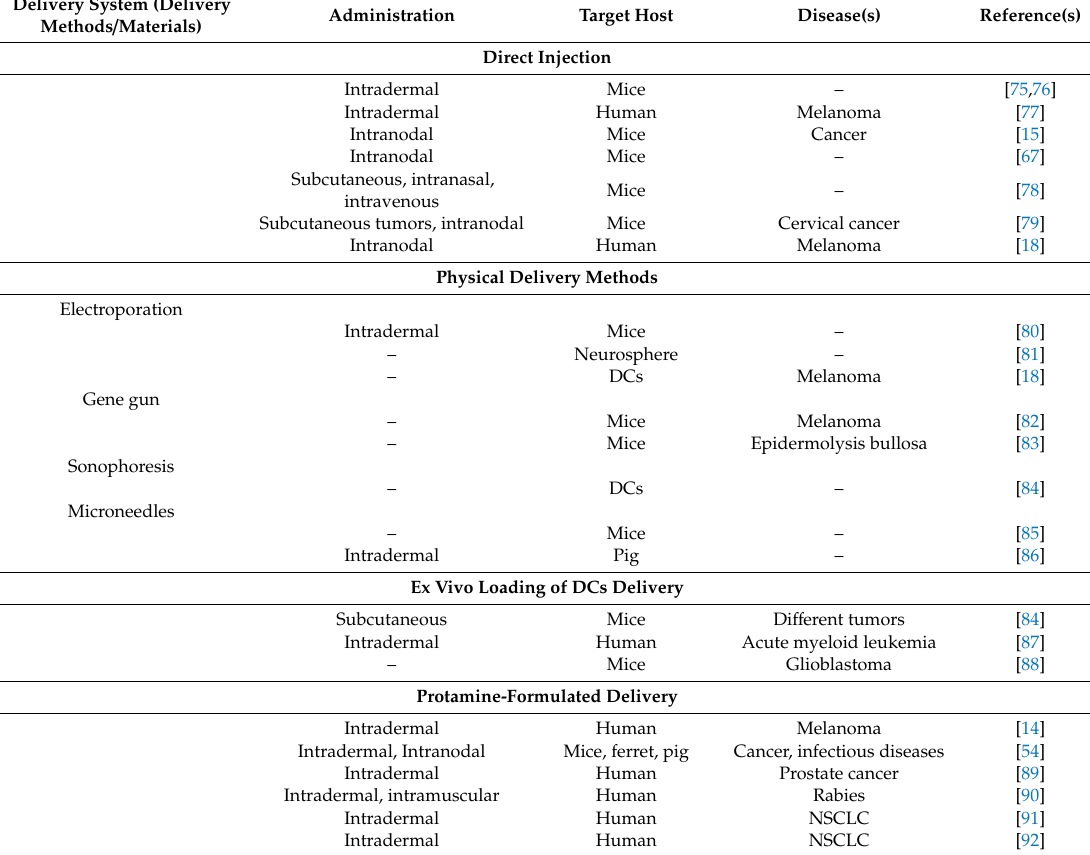
Table 1. Examples of mRNA delivery